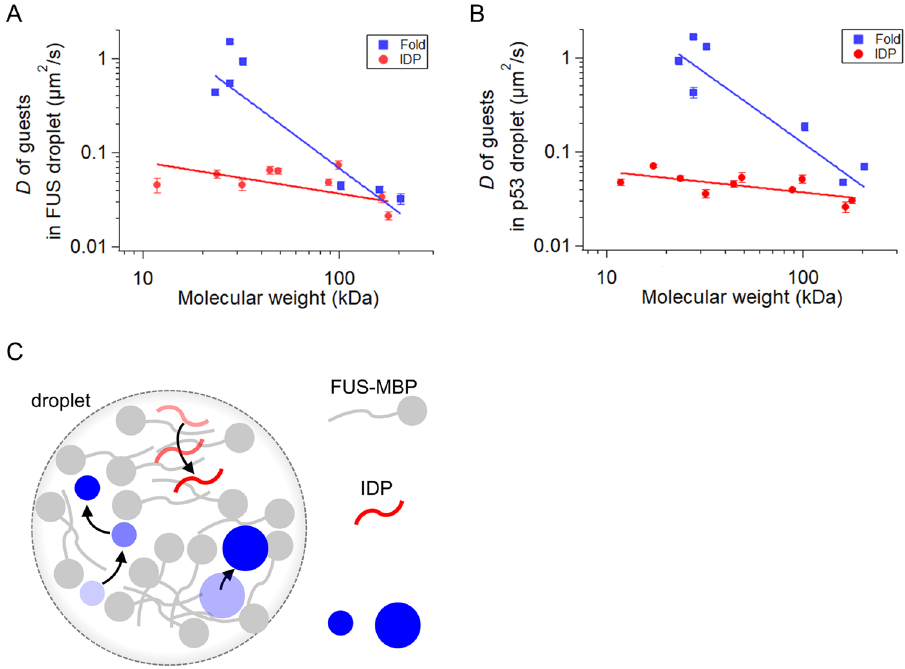
Figure 4. Scaling of diffusion of guests in droplets and diffusion model. ( A , B ) Diffusion of guest proteins in FUS ( A ) and p53 ( B ) droplets as a function of molecular weight. Blue and red plots represent the data for folded proteins and intrinsically disordered proteins (IDPs), respectively. Solid lines are best-fitted ones of a power-law dependence. The molecular weight of guest proteins, obtained using Expasy, includes that of fluorescent dyes. The D values in p53 droplets were plotted from the Ref. 13 . ( C ) Proposed model of structure-dependent diffusion in a FUS droplet. The droplet (dashed grey circle) is formed by host FUS-MBP (grey). IDP (red) diffuses slowly while interacting with host FUS molecules. Large folded protein (large blue circle) diffuses slowly while being trapped inside the small voids of the droplet. In contrast, a small folded protein (small blue circle) diffuses quickly moving through the droplet